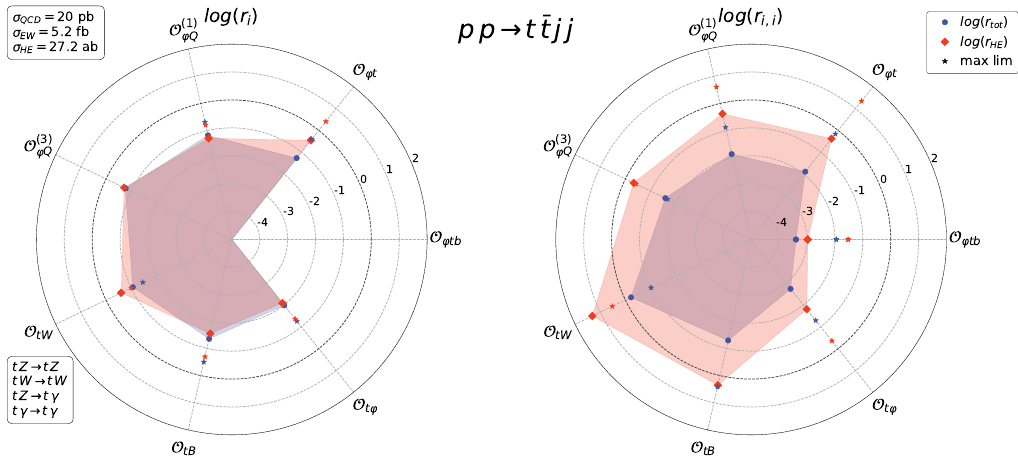
Figure 30. Radar plot for the VBF t (cid:22) t production process at the 13 TeV LHC, see (cid:12)gure 7 and section 4.1.2 of the main text for a detailed